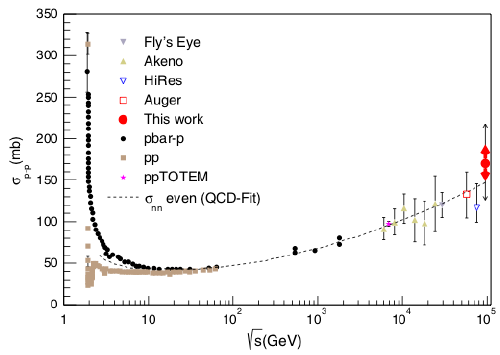
p Figure 6. The (cid:27) tot s . The result of this work is as a function of p (cid:0) p shown by a red filled circle with long and short arrows indicating statistical and systematic errors, respectively. (Figure from FIG. 9 (color online). The proton-proton cross section vs the center of mass energy result of this work, including the statistical (outer/thinner) and systematic (inner/thicker) error bars. The ¯ pp and the pp data are shown in smaller darker circles and square symbols consecutively [41]. The recent result from LHC is also shown by the star marker [42]. The result of this work is shown in comparison to previous work by cosmic rays detectors ([1,2,29,32]). The dashed curve is the QCD inspired fit by BHS [7].